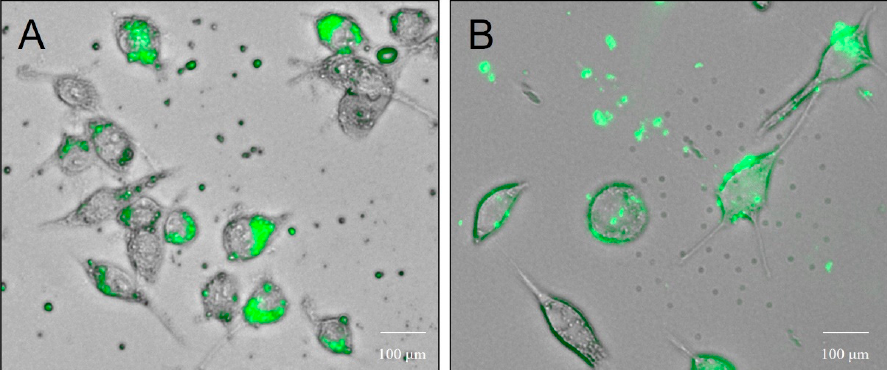
Figure 4. Dendritic cell (DC) uptake microparticles. Representative images of the uptake of microparticles by antigen presenting dendritic cells observed using the fluorescence microscope ( A , B ). The FITC-BSA microparticles were rapidly taken up by the dendritic cells and were accumulated in the cytosol and the vacuolar compartments (40 × ).